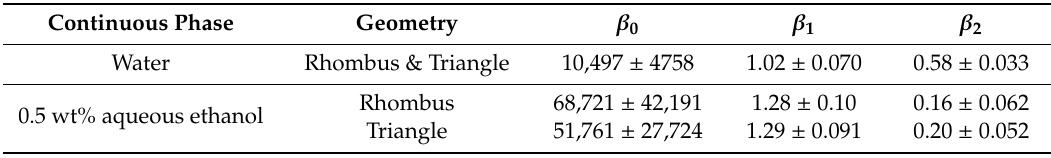
Table 2. Correlation parameter values and 95% confidence intervals for the tested geometries and continuous phases. For the CO 2 -water and rhombus data, 214 < Re l < 856 and 0.15 < u g / u l < 36.5. For all other data, 214 < Re l < 428 and 0.14 < u g / u l < 18.0.